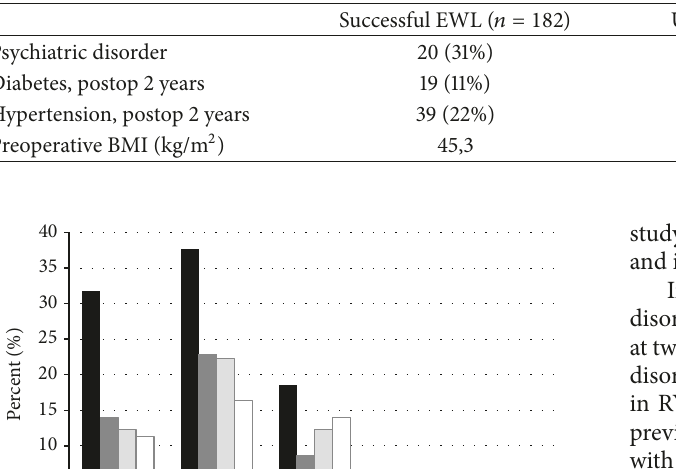
Table 4: Logistic regression analysis correlating preoperative clinical factors and successful versus unsuccessful weight loss in patients following RYGB at 2-year follow-up. Only significant data arepresented. Data expressed as 𝑛 (%) for nominal variables or mean for continuous